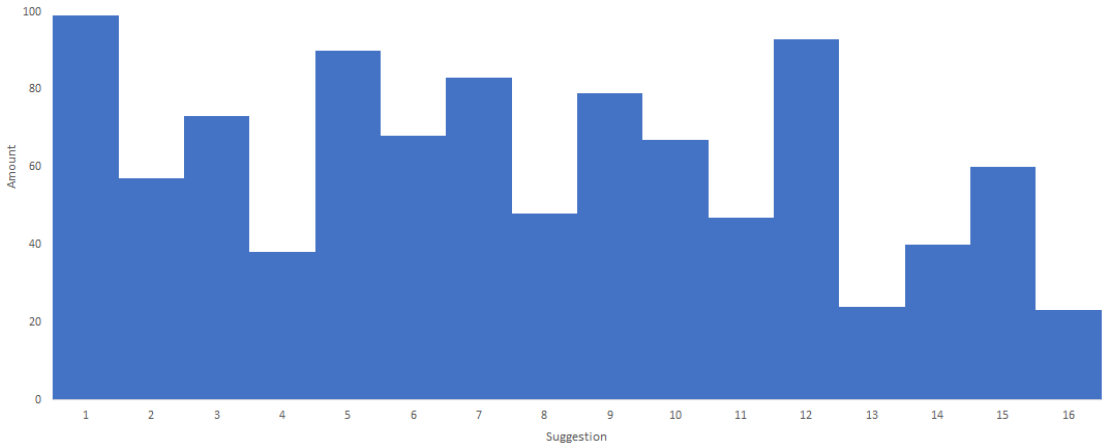
Figure 7. Distribution of the exercises using the new algorithm applied to the problematic scenario.